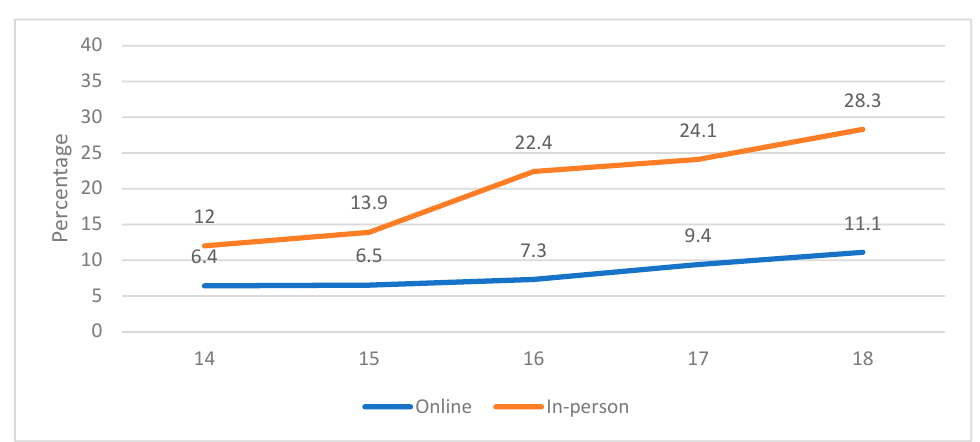
Figure 1. Gambling frequency by modality and age.